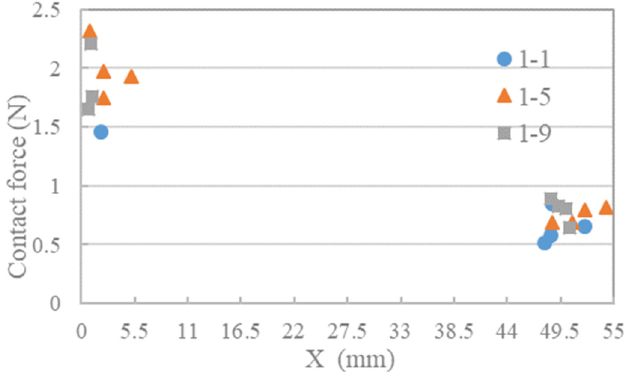
Figure 17. Contact force distribution.